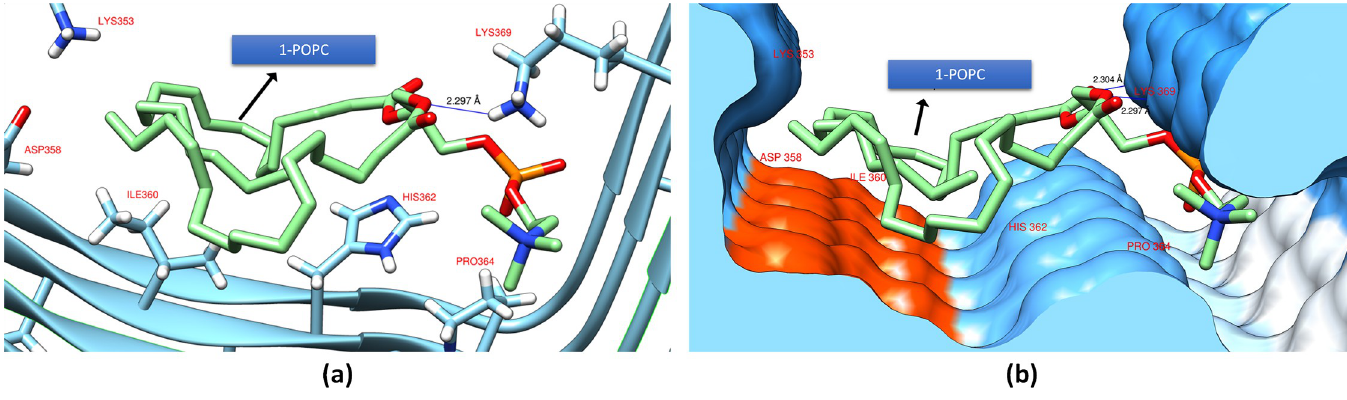
Fig 4. (a) The docking conformation of 1-POPC on PHF-Tau showing the H-bond formation between 1-POPC and the PHF-Tau backbone. (b) Electrostatic surface potential model on the docking site of 1-POPC ON PHF-Tau which shows the hydrophobicity of the binding site (blue regions are hydrophilic and red orange regions are hydrophobic).